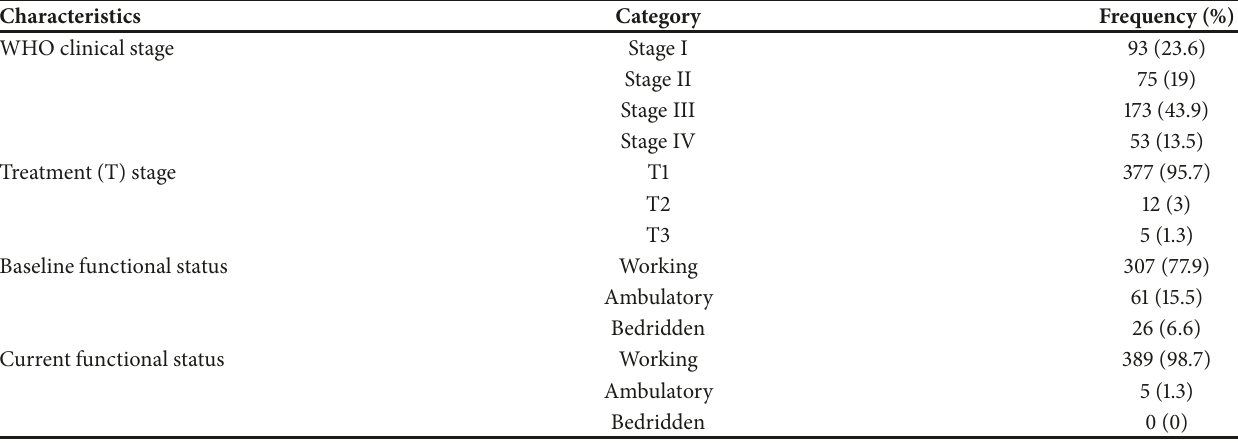
Table 2: Clinical characteristics and health conditions among patients with HIV/AIDS.